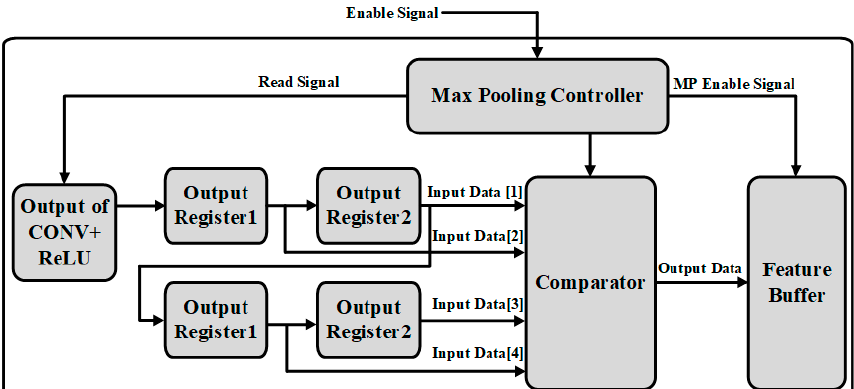
Figure 10. The architecture of the max-pooling operation.